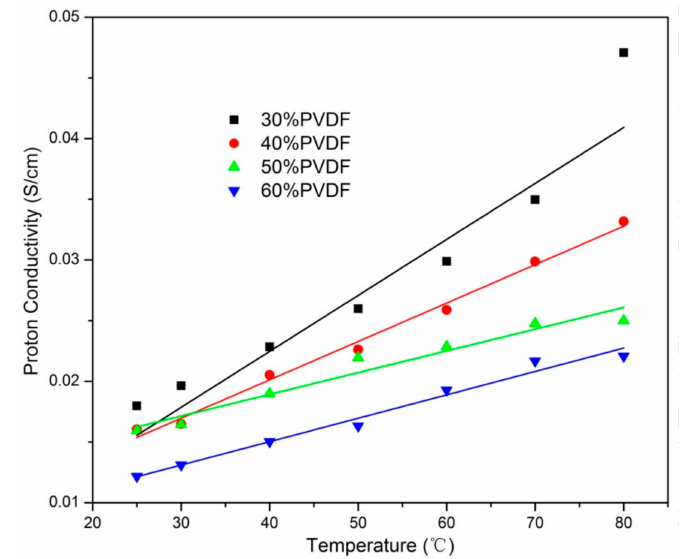
Figure 5. Temperature dependences of proton conductivity of the s -PI-PVDF composite membranes. Table 1. Water uptake, volume swelling and ion exchange capacity ( IEC ) of s -PI-PVDF composite membranes and Nafion